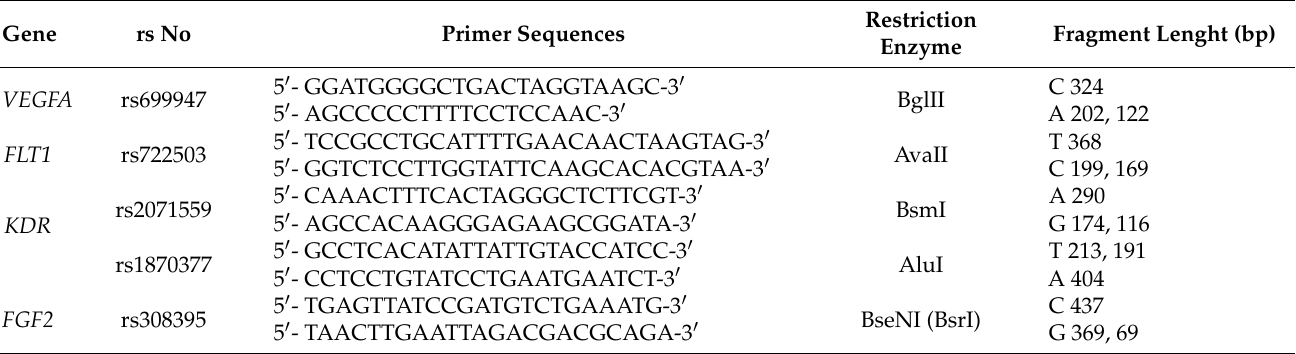
Table 8. PCR-RFLP assays used in the genotyping of study